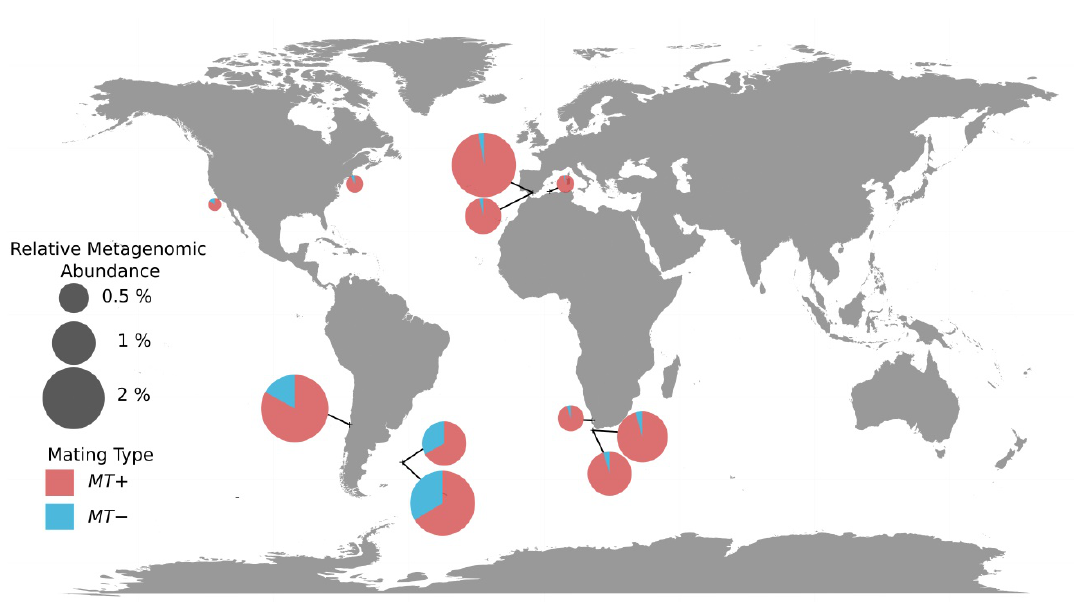
Figure 4. Geographical distribution of the two mating types of Ostreococcus lucimarinus in Tara Oceans stations. Each pie-chart represents a sample with a size relative to the relative metagenomic abundance of whole genome, and shows the average proportions of the two mating types genes. Ratios were determined using the MT genes method (Methods).